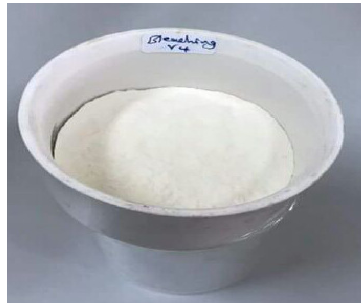
Fig. 3. The sample after